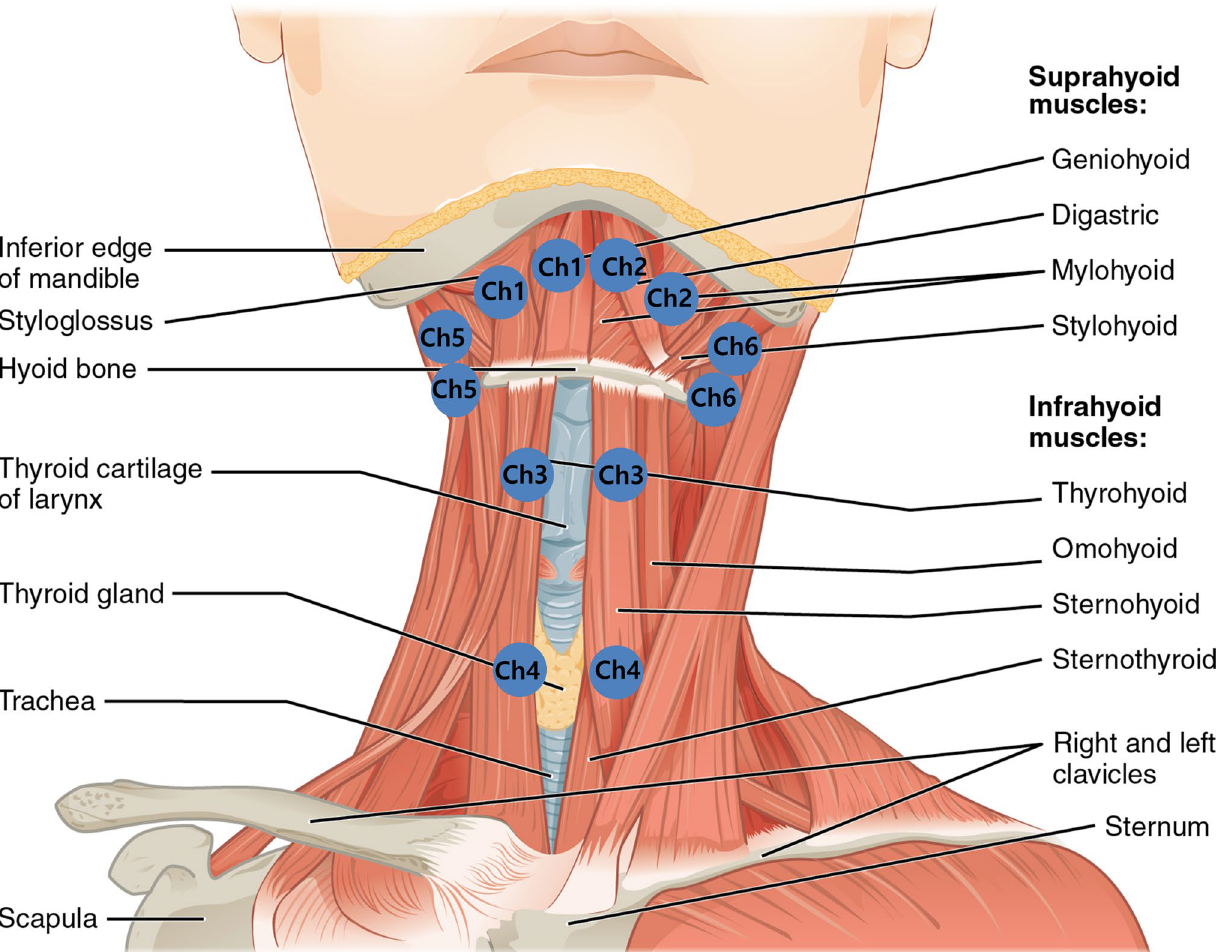
Figure 1. Locations of S-EMG electrodes (channel 1, 2: bilateral right suprahyoid muscles, channel 3: thyrohyoid muscle, channel 4: sternohyoid muscle, channel 5, 6: bilateral retrohyoid muscles). The copyright owner is OpenStax (Source: https ://cnx.org/conte nts/FPtK1 zmh@8.25:fEI3C 8Ot@10/Prefa ce). JS Ryu recreated the drawing by adding electrodes to the original